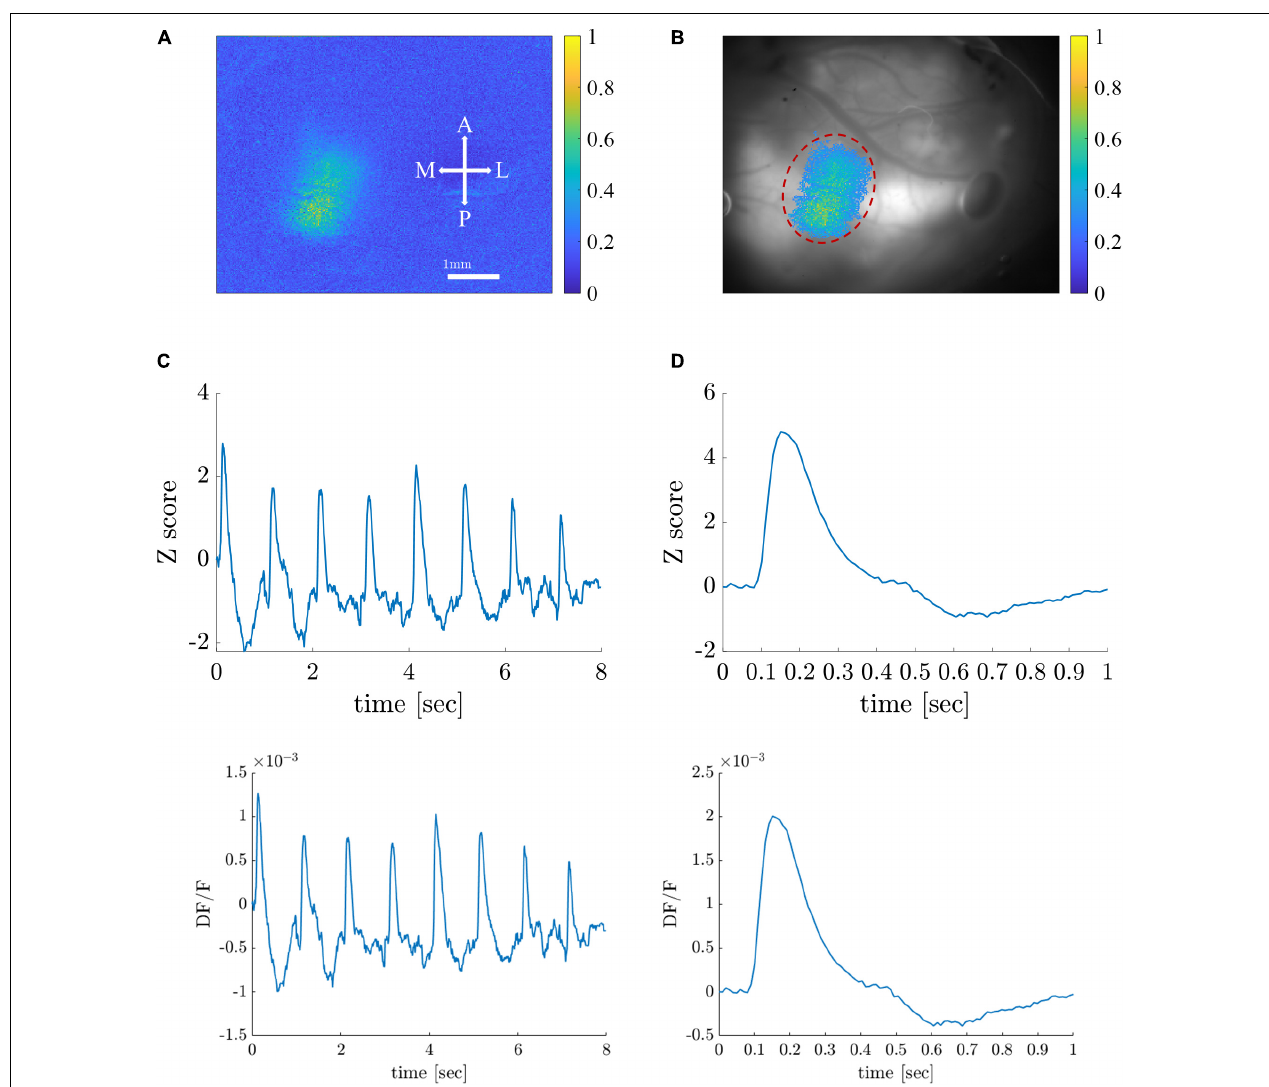
FIGURE 5 | Visual cortex responses to short visual stimuli. (A) A color map representation of the cortical response amplitude (normalized Z-score) induced by visual stimuli. Scale bar and map orientations are overlaid. A, anterior; P, posterior; M, medial, and L, lateral. (B) Image of the brain overlaid with corresponding pixels in the visual cortex ROI (dashed red line). (C) A raw (z-scored) VSD signal in response to 8-grid stimuli given at a rate of 1 Hz in the ROI. (D) Characteristic average response to a single